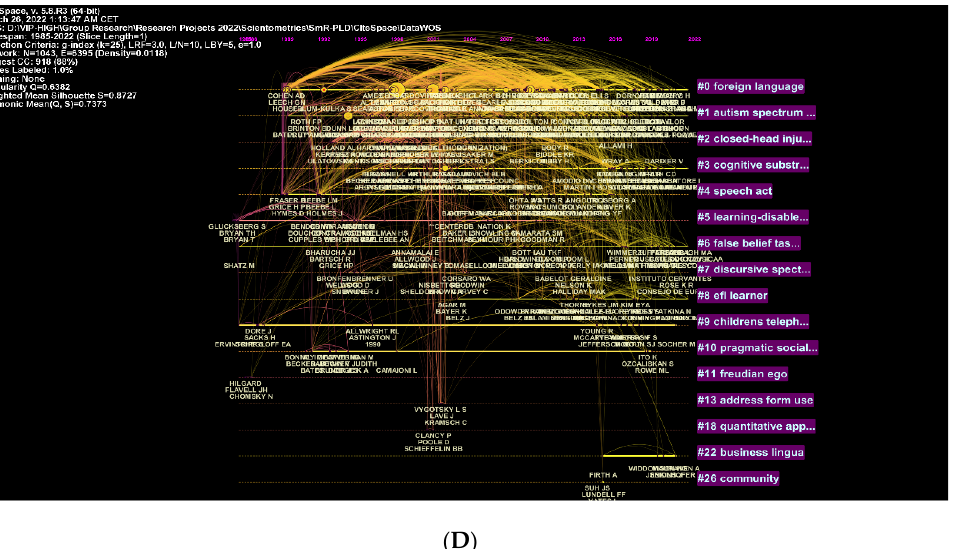
Figure 9. Timeline of top keywords, cited authors, and clusters: ( A ) Scopus; ( B ) WOS; ( C ) Scopus— cited authors; ( D ) WOS.